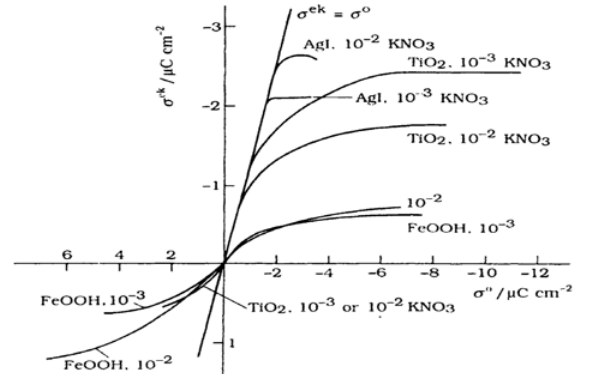
Figure 7. Comparison between electrokinetic ( σ d ) and surface charges ( σ °) for a number of amphoteric model colloids. Taken from Ref. 32 with permission. Copyright © 1995 Academic Press. Published by